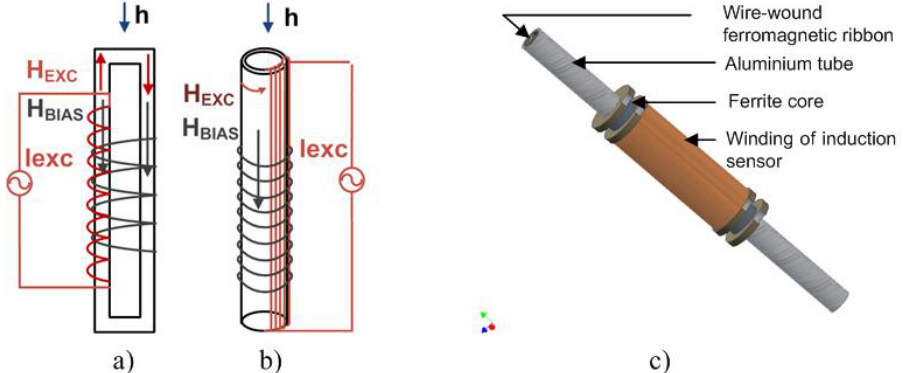
Figure 4. Racetrack (a) and cylindrical (b) wire-wound ferromagnetic core. (c) Hybrid sensor: induction sensor and wire-wound GMI inside an aluminium tube.